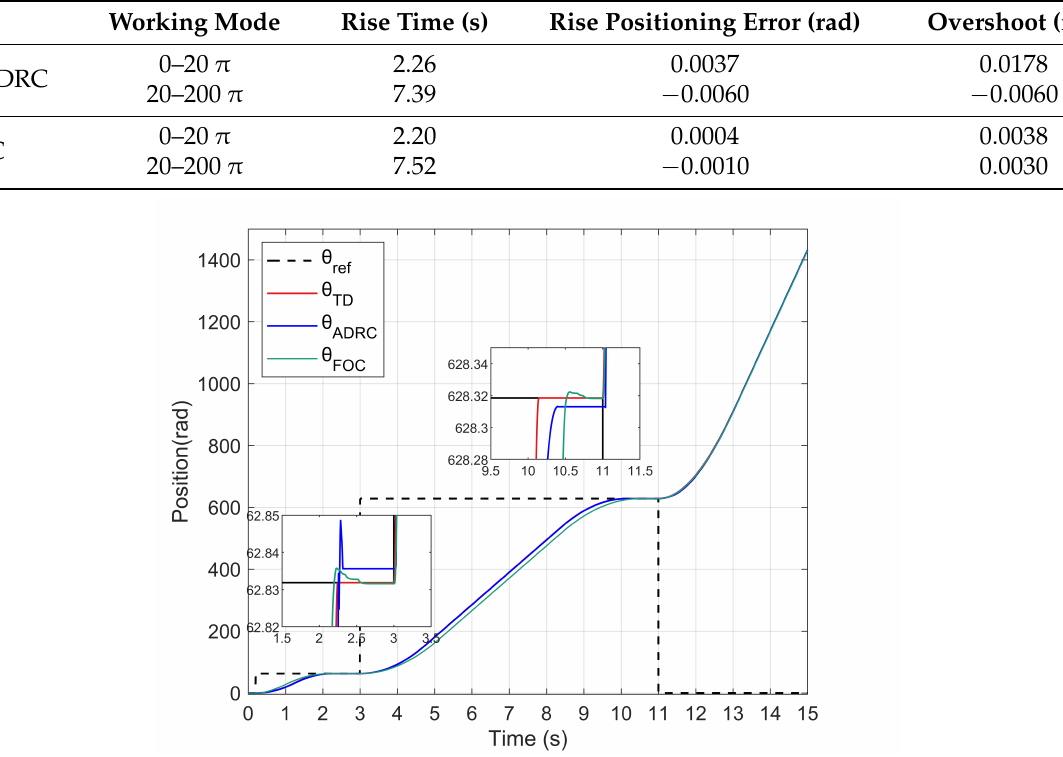
Table 3. Performance indexes of improved ADRC and PI + FOC.